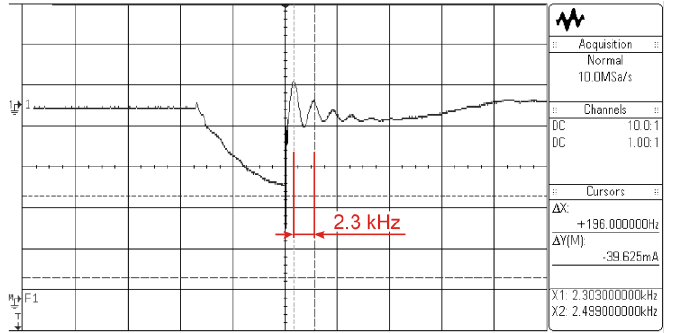
Figure 8. Details of simulated switching processing of SiC power component used in aircraft power electronics.